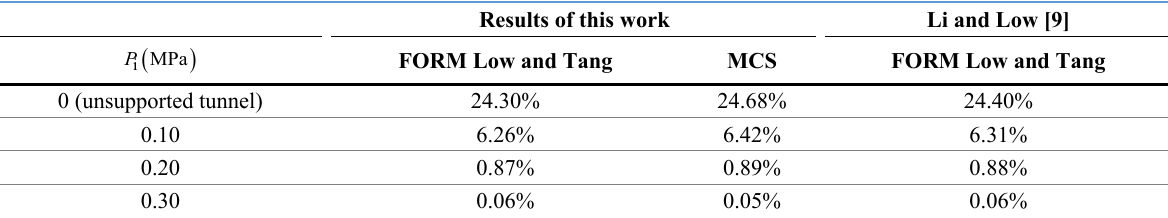
Table 4: Failure probabilities results f p considering tunnel A. Results of this work Li and Low [9]